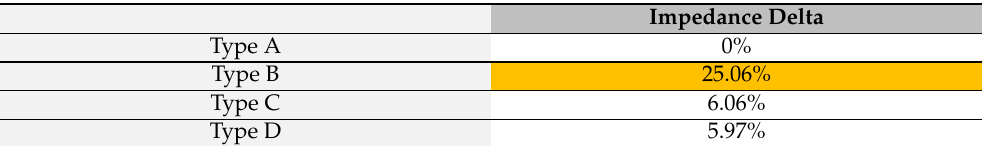
Table 3. Impedance deviation of each structure type. In the case of Type B, the impedance deviation is exceeded 10%, as shown in the yellow background of the